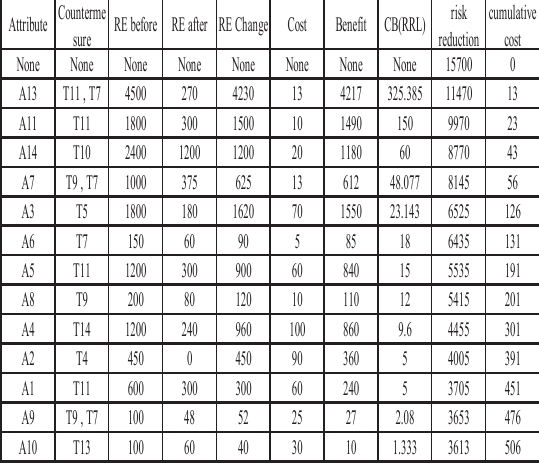
Table 5: The Optimal Strategy Computed For The Matrices In Tables (1 -